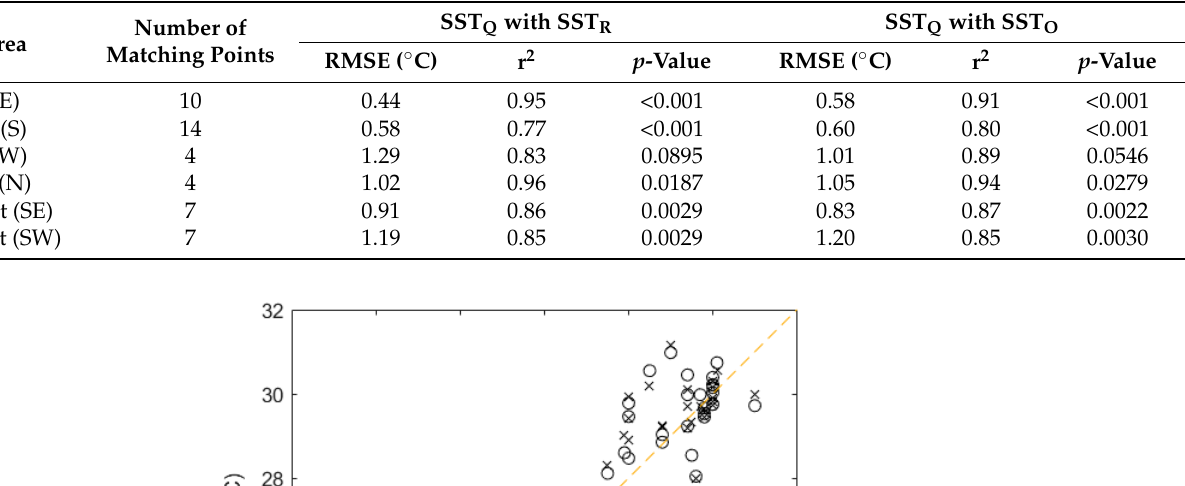
Table 2. Statistic results of the comparison between SST Q and SST R /SST O in the six areas.